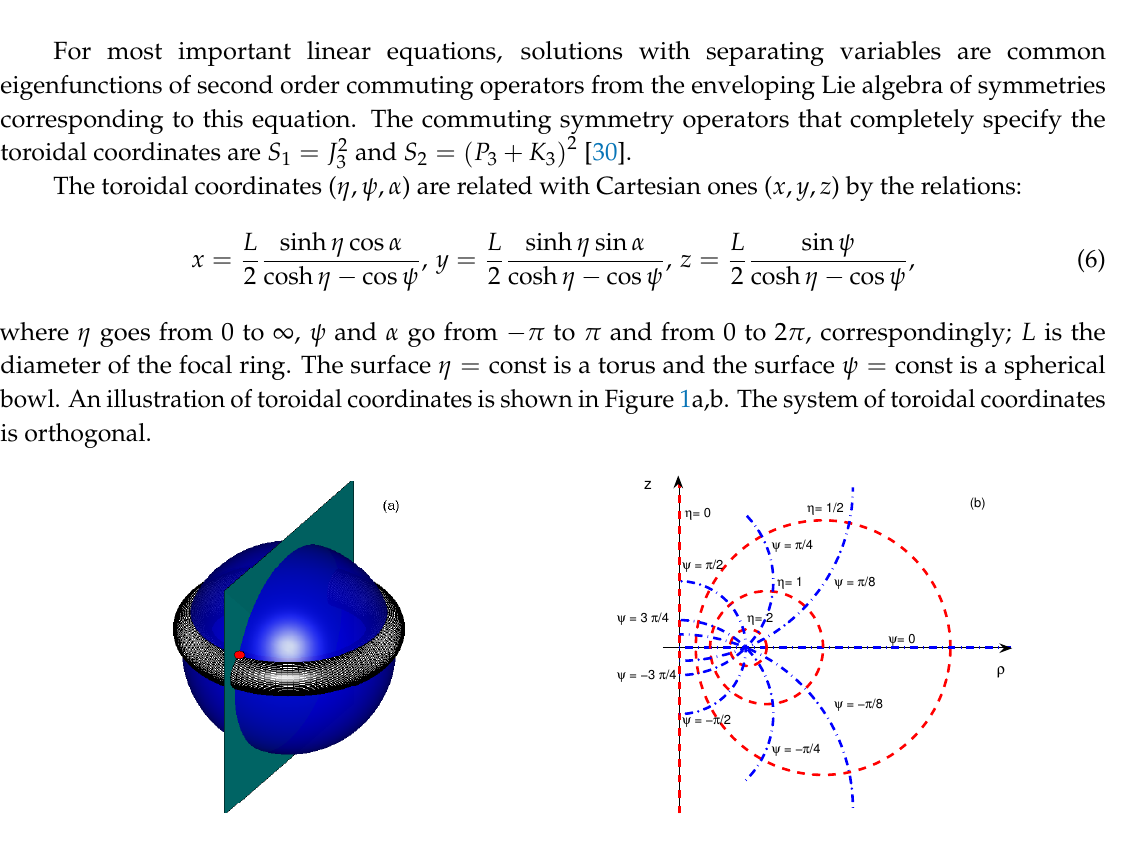
Figure 1. Schematic illustration of toroidal coordinates. ( a ) The toroidal coordinates of any point are given by the intersection of a sphere, a torus, and an azimuthal plane. Spheres of different radii that pass through the focal ring are specified by coordinates ψ . The surfaces of constant η are non-intersecting tori of different radii. The coordinate α is the azimuthal angle about the z axis. ( b ) The right panel shows circles of constant η and ψ observed in the section of the azimuthal